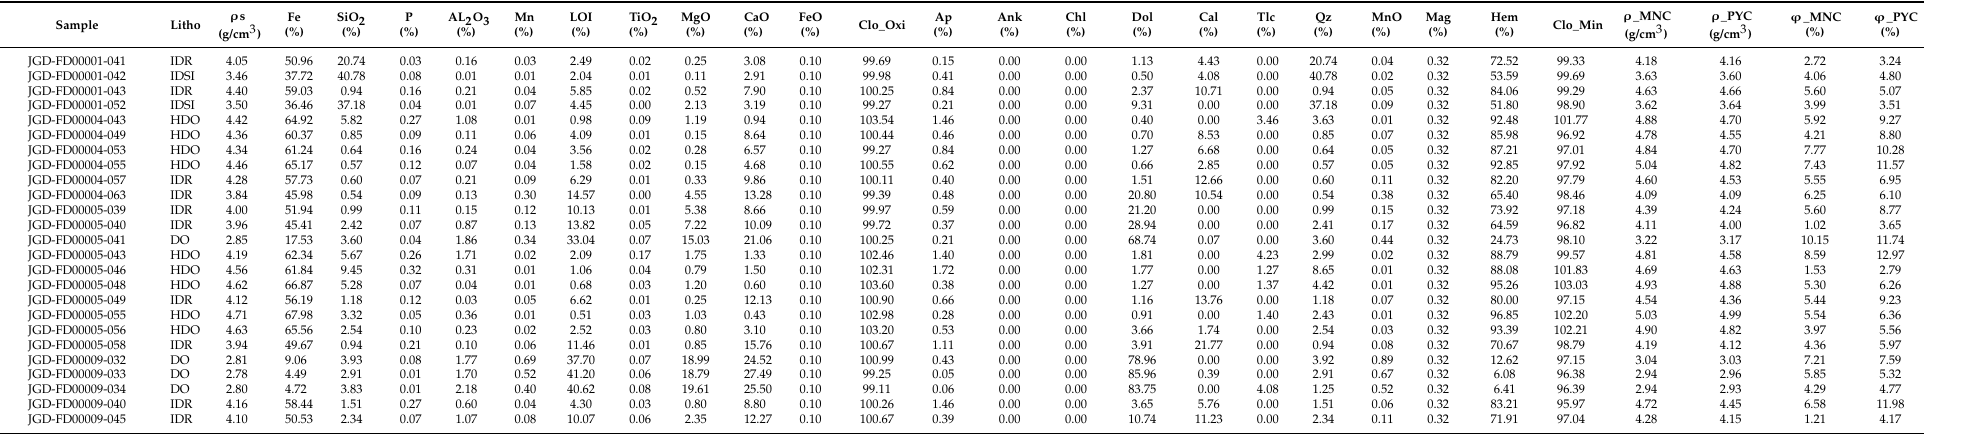
Table A2. Original unweathered sample data with lithology, chemical grades, bulk density, moisture, and mineral density (PYC) measurements and calculated mineral proportions, mineral density (CNM), porosity (CNM and PYC), and saturation (CNM and